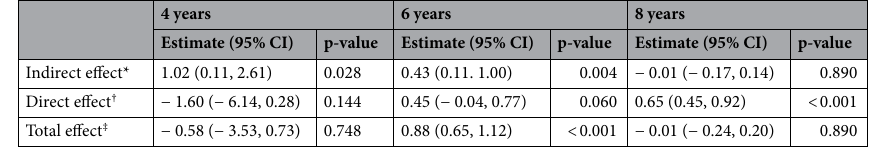
Table 4. Mediation analysis of the path from prenatal exposure to SO 2 to ADHD rating scale (ARS) at 4, 6 and 8 years of age through DNAm at cg07583420 ( INS-IGF2 ). *Indirect effect refers to prenatal exposure affecting ARS through DNAm at cg0783420. † Direct effect refers to prenatal exposure directly affecting ARS not through DNAm. ‡ Total effect refers to the sum of indirect effect and direct effect.